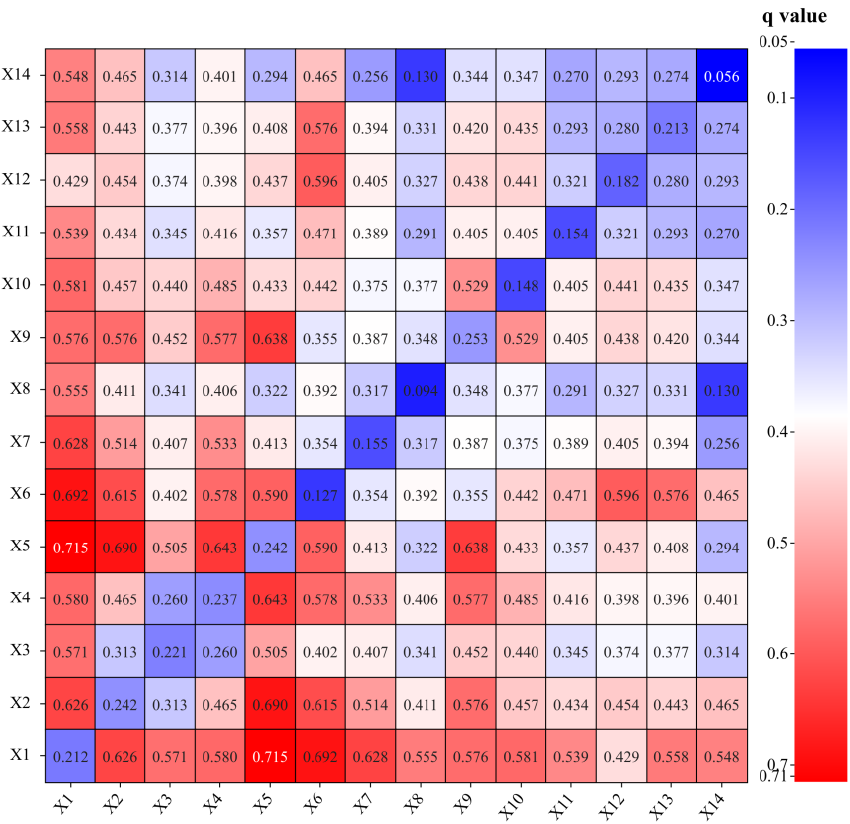
Figure 9. Heatmap of the interaction between factors influencing spatial difference in CLF in Guang- dong Province. X1, X2, X3, X4, X5, X6, X7, X8, X9, X10, X11, X12, X13 and X14 refer to mean patch area of cultivated land, forest area ratio, altitude, slope, per capita regional GDP, construction land area ratio, proportion of industry and service industry, per capita disposable income of all residents, population density, per capita cultivated land area, urbanization rate, agricultural output value, agricultural practitioners and grain production,